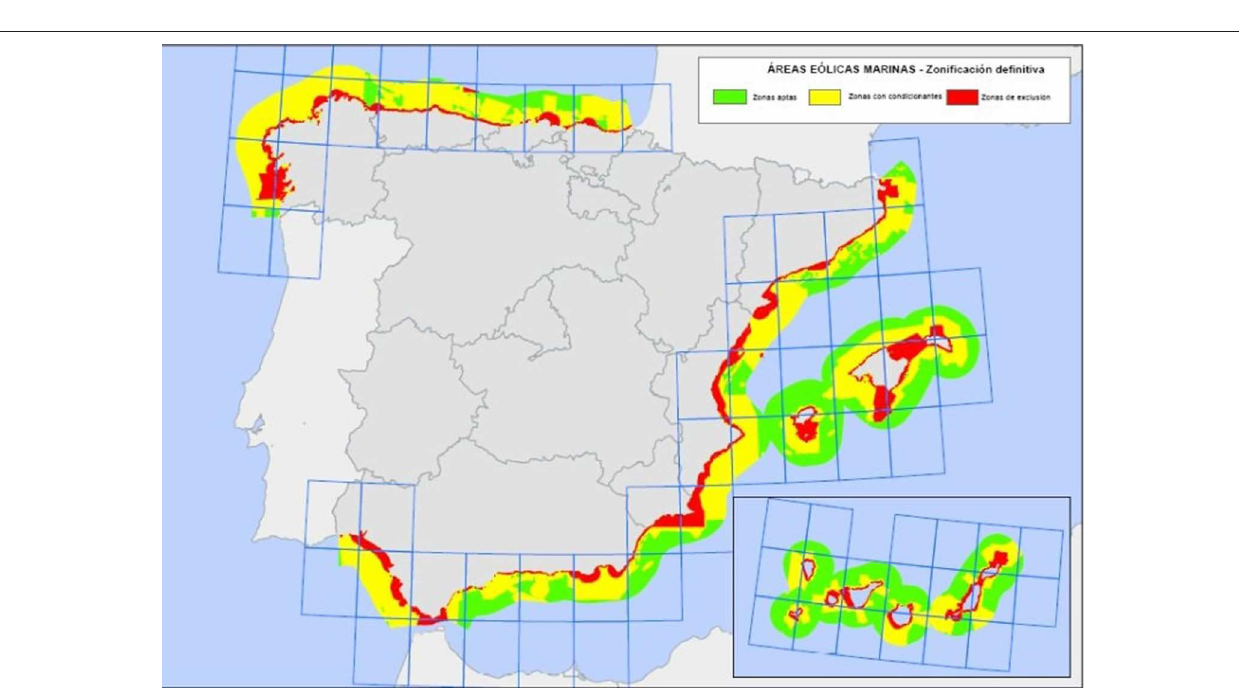
excluded, but marked as yellow, which means that is apt for the installation of a wind farm but particular considerations must be accounted